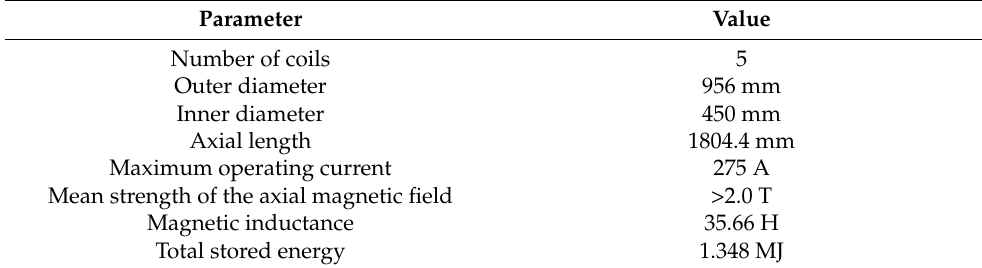
Table 2. Parameters of superconducting magnet